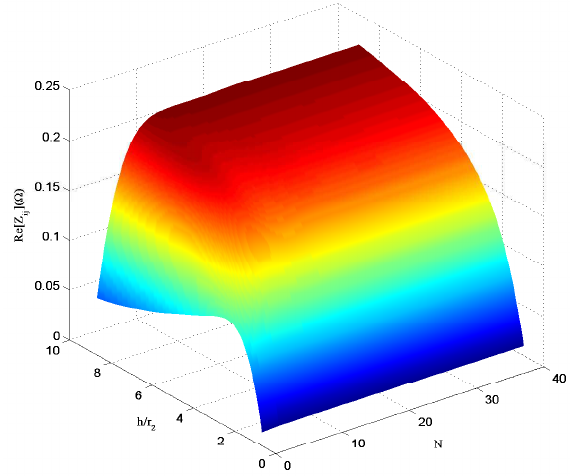
Figure 3. The influence of N and h on the real part of mutual impedance.